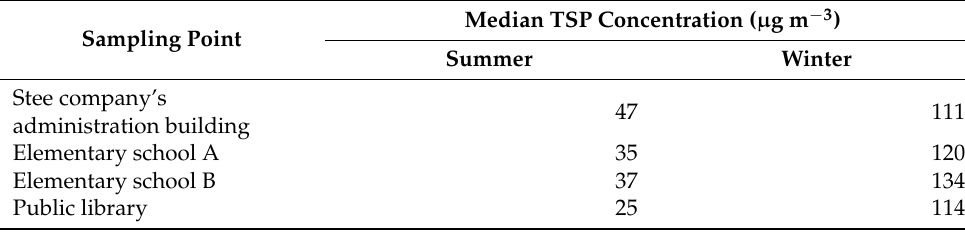
Table 1. Median TSP concentrations at the four sampling points. Sampling